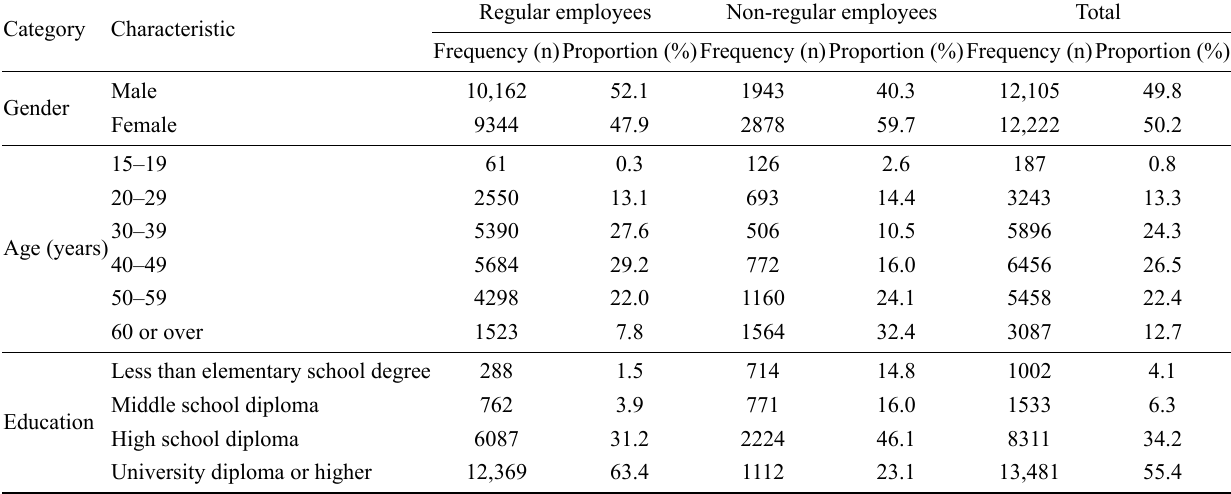
Table 1. Demographic